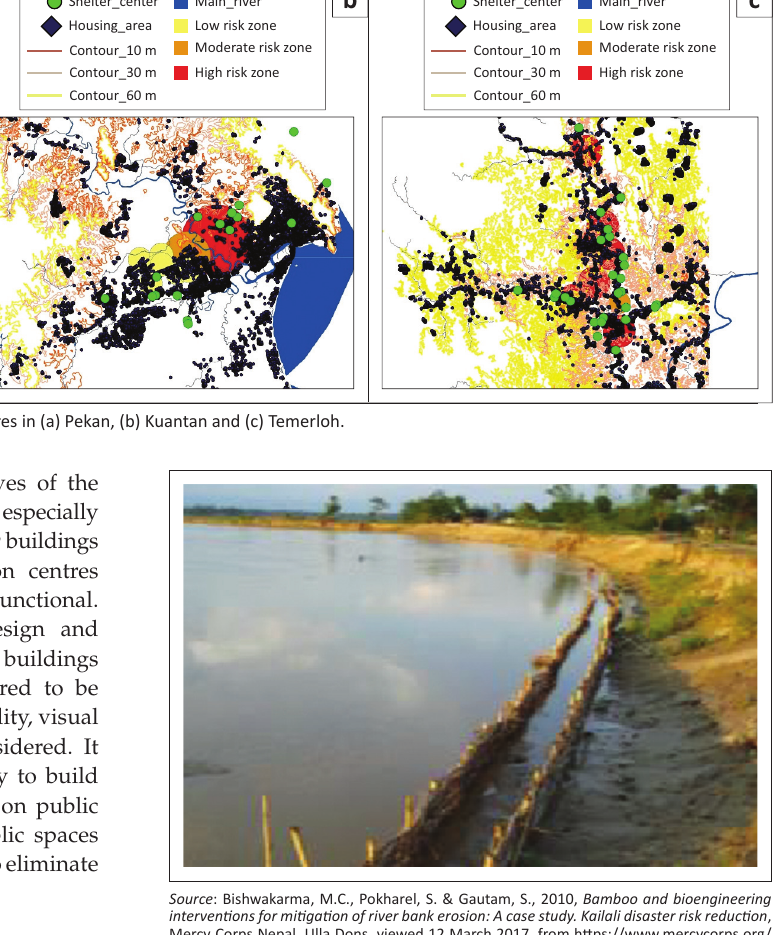
FIGURE 4: Bamboo crib wall constructed to prevent bank erosion in